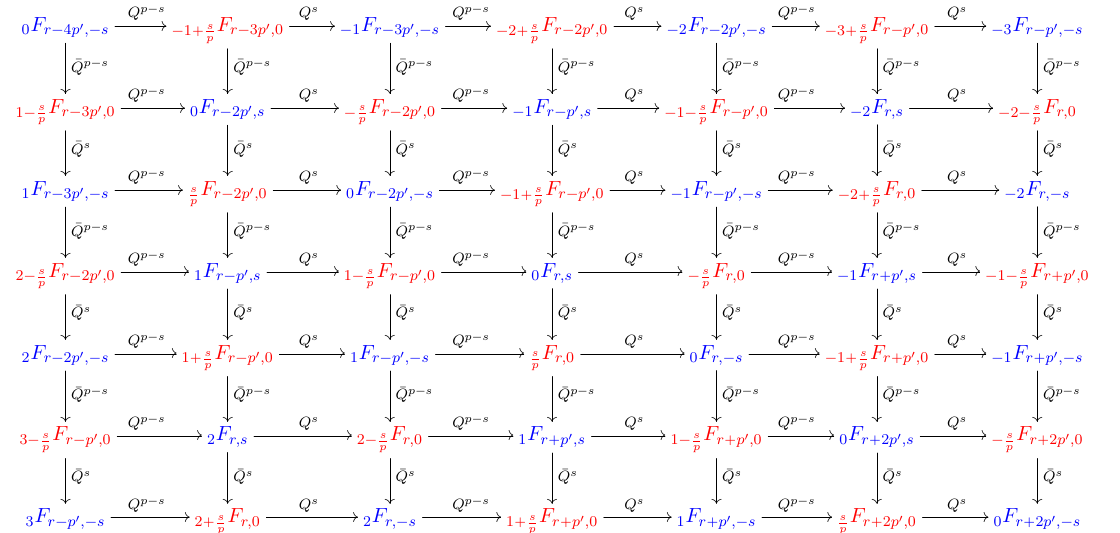
Figure 7 . Structure of the full BRST